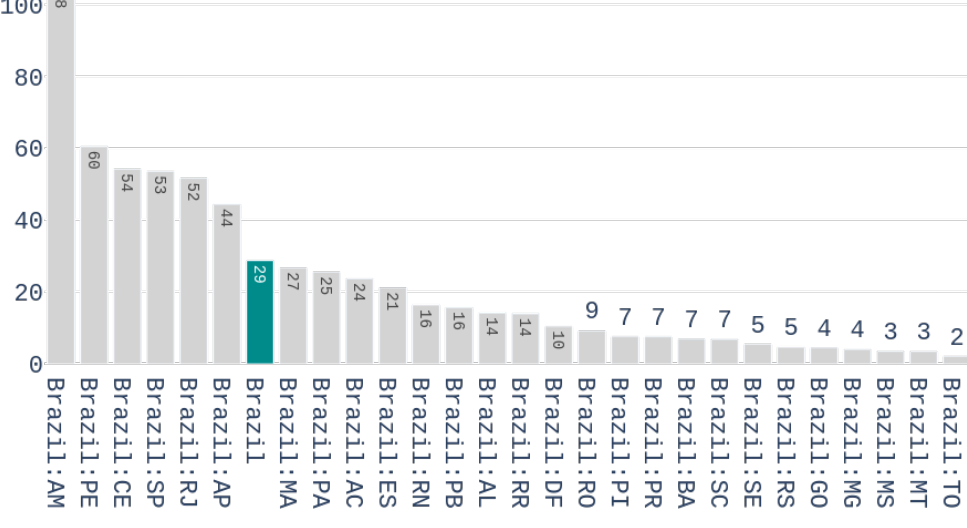
Figure 3. Number of deaths per million inhabitants in the different Brazilian states on 1 May